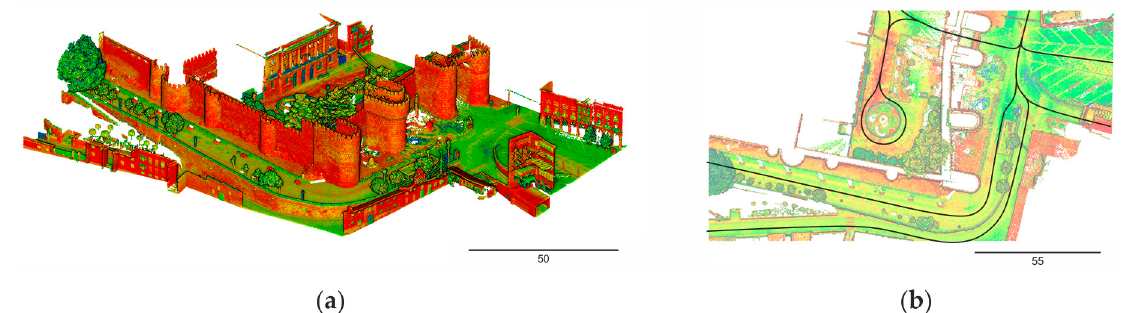
Figure 6. Color-coded mobile laser system (MLS) data acquisition: ( a ) point cloud; ( b ) schematic view of the path followed during the scanning.